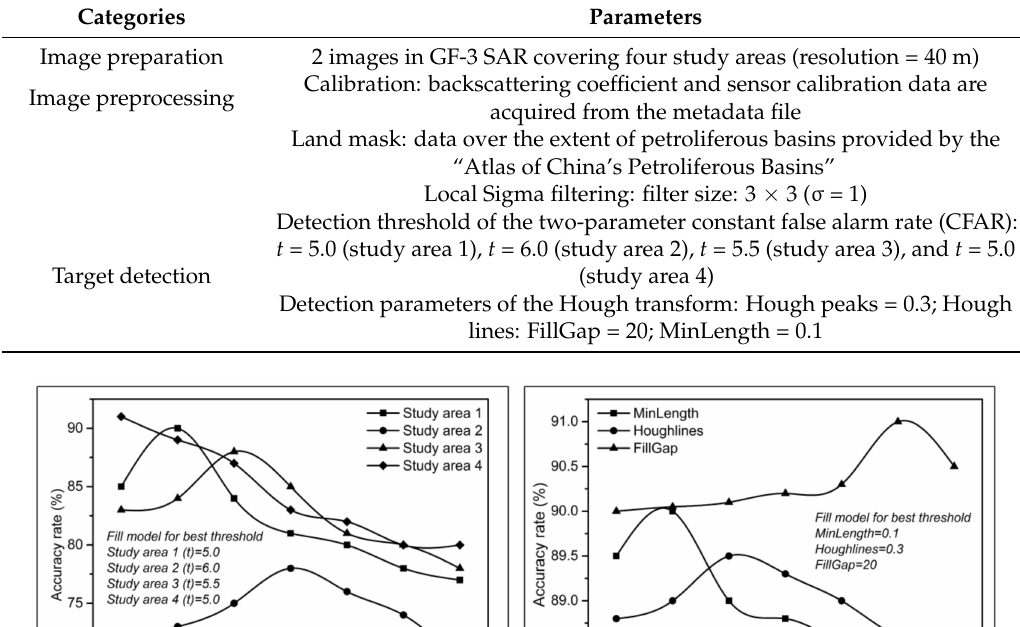
Table 6. Parameters used in the automatic extraction method of offshore platforms.